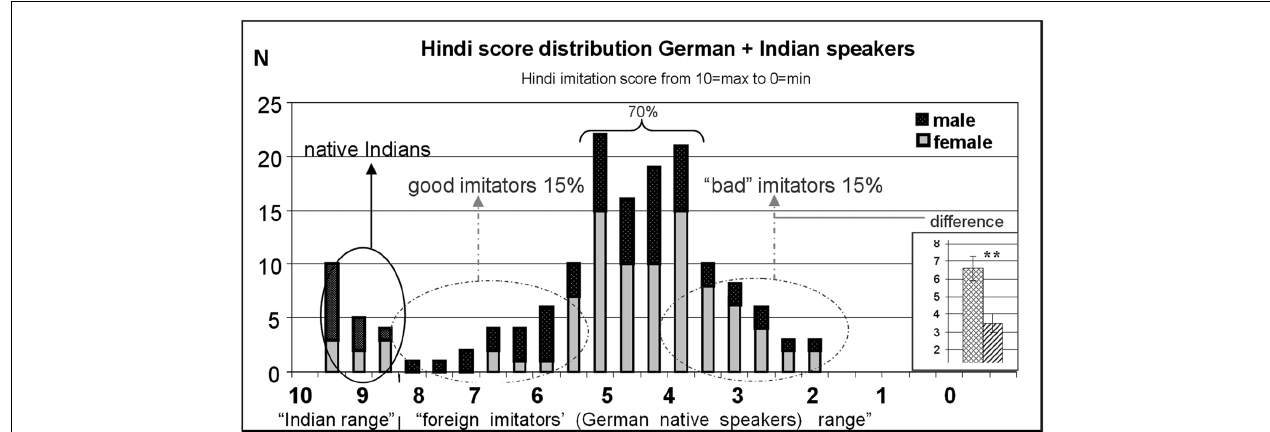
between 0 and 10 without demarcated increments to ensure intuitive and quick rating.The 18 Indian natives scored on the first 18 places. More German males (black) are amongst the good imitators (15%). Most German subjects scored average (70%).The score difference between the low ability “unsuccessful” 15% and the upper range or high ability 15% “successful” German imitators was significant at p = 0.000** (SD ± 0.3 upper group; SD ± 0.6 lower